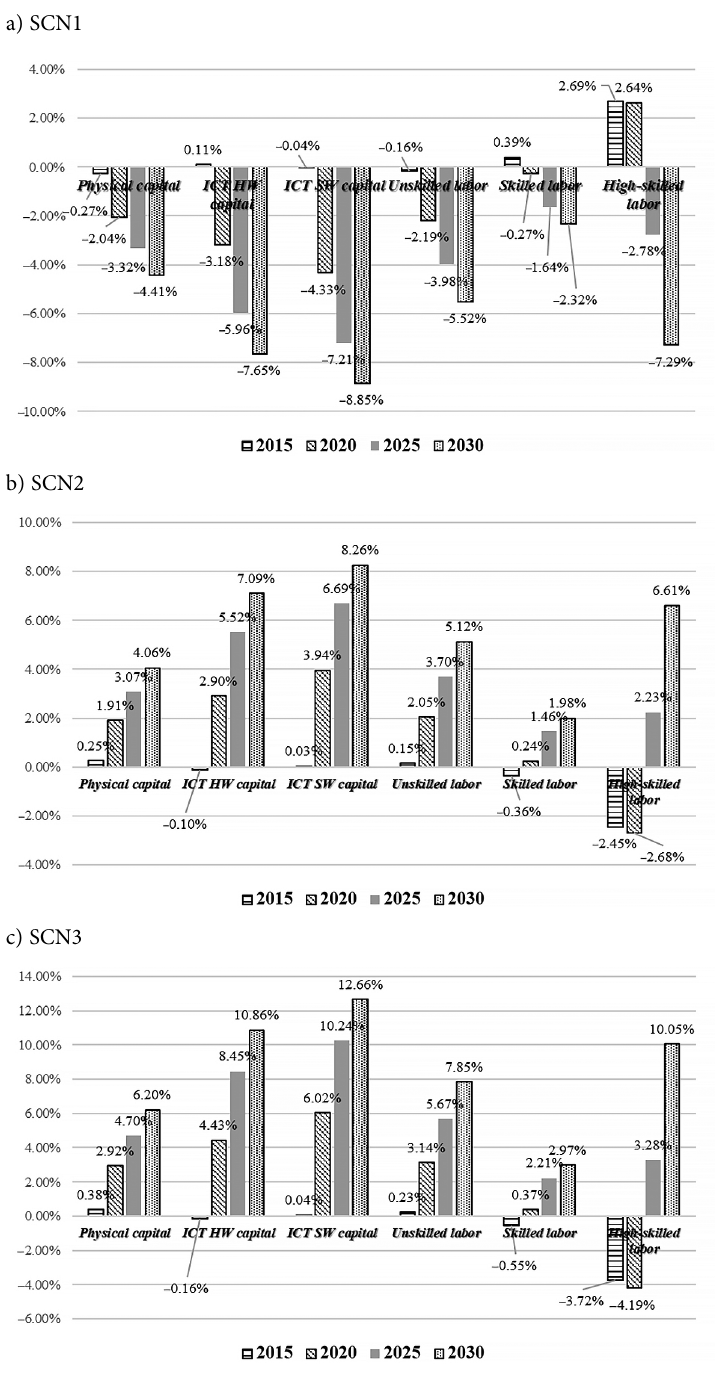
Figure 4. Changes of the value-added in policy scenarios (% relative to